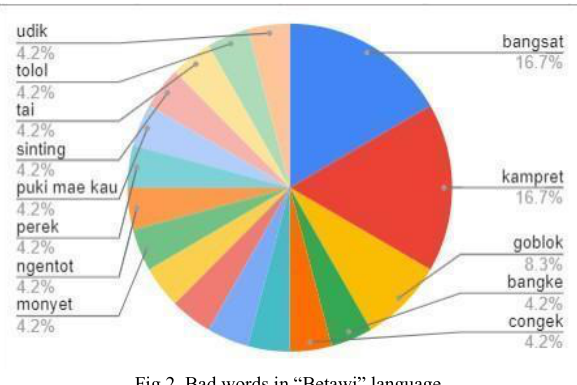
Fig 2. Bad words in “Betawi” language